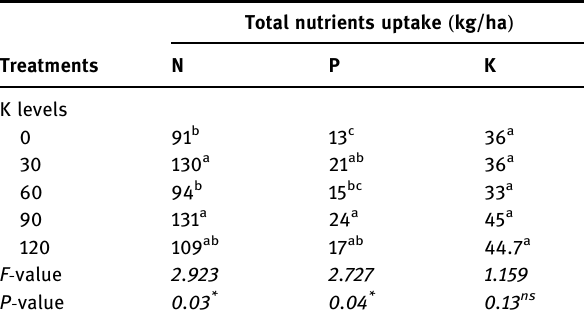
Table 3: E ff ect of potassium fertilizer application on N, P, and K uptake ( kg/ha ) by te ff crop